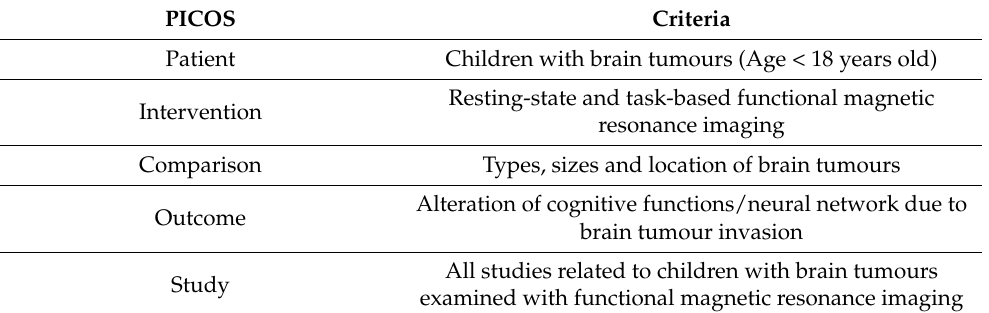
Table 1. PICOS strategy for the selection of